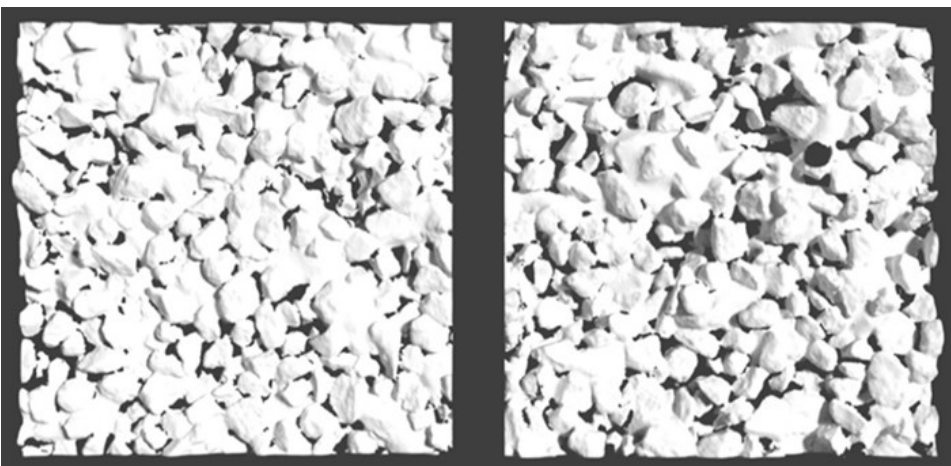
Figure 11. A 3D scan image of the area subjected to APT loading (left) and the adjacent area (right) that received no loading.